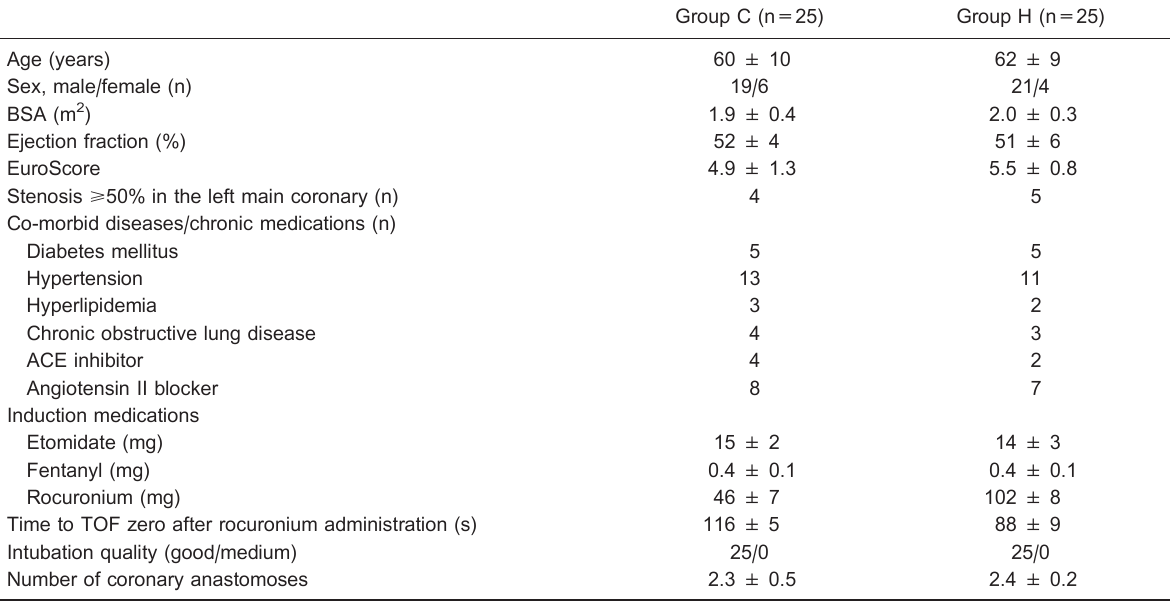
Table 1. Patient characteristics, drug requirements, intubation times, and number of coronary